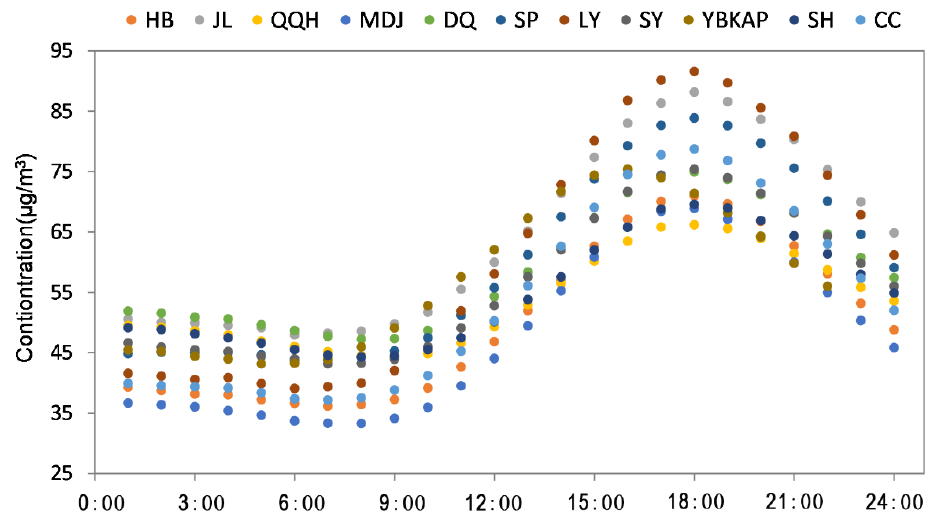
Figure 7. Hourly O 3 concentration from 2015 to 2019.